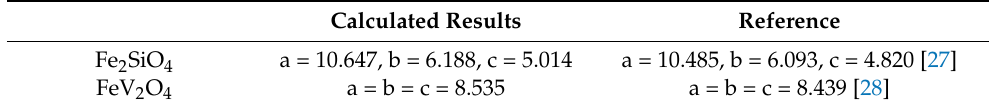
Table 1. Lattice parameters of Fe 2 SiO 4 and FeV 2 O 4 .